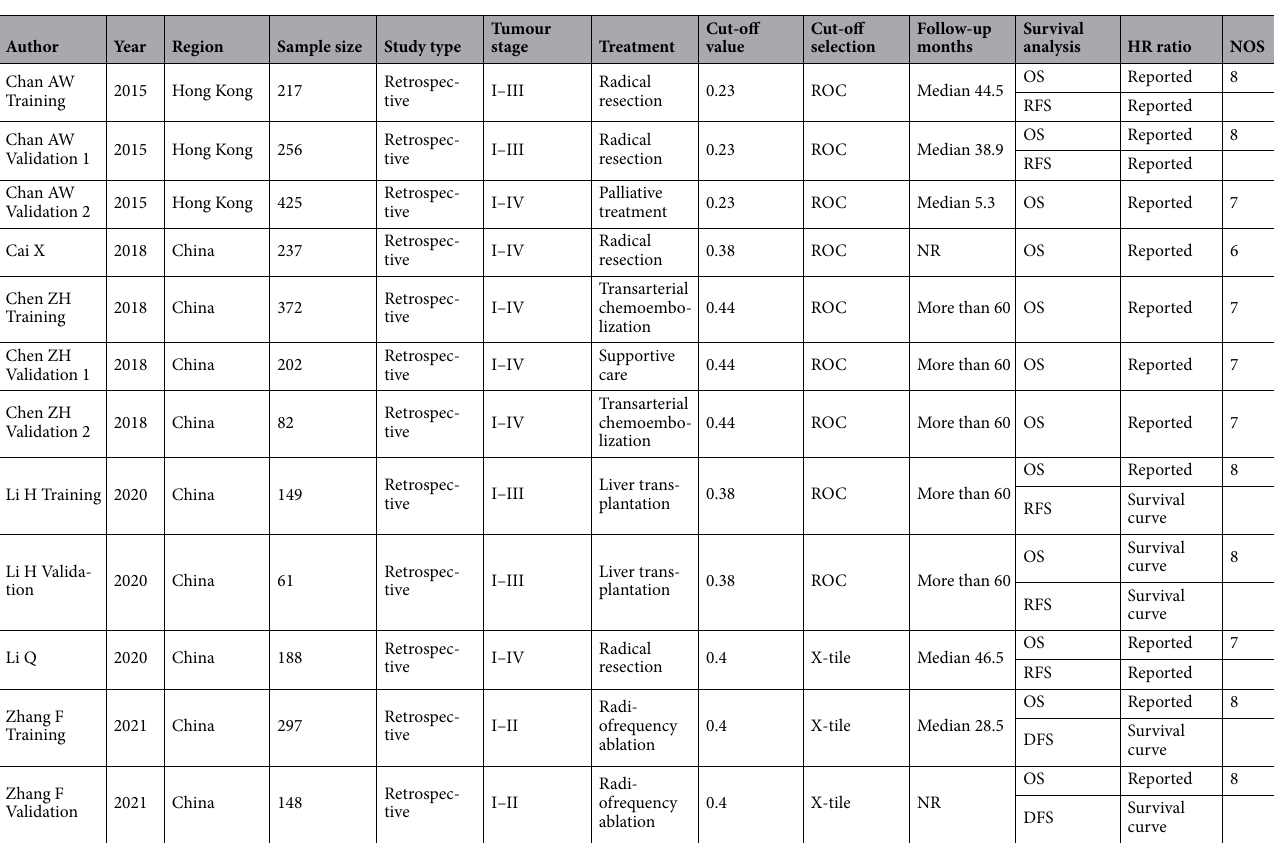
Table 1. Main characteristics of the included studies. Palliative treatment: transarterial chemoembolization, systemic chemotherapy and supportive care; ROC the receiver operating characteristic, OS overall